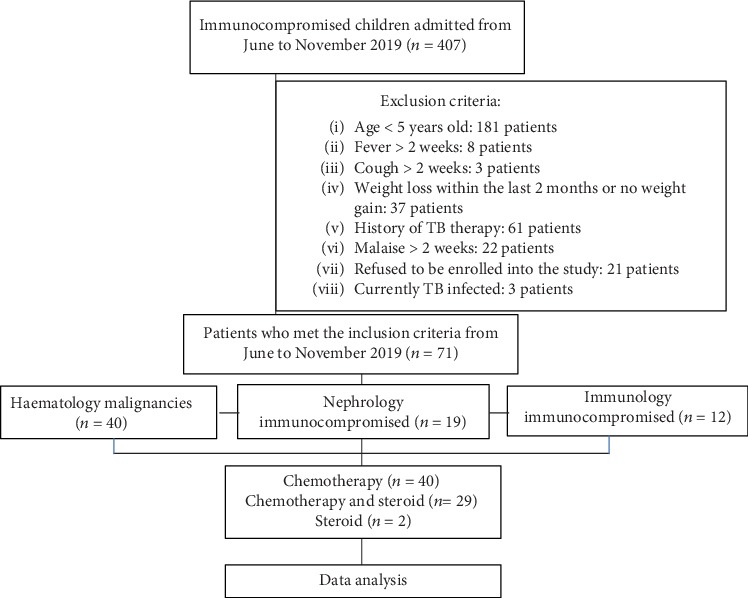
Flow diagram. TB: tuberculosis.